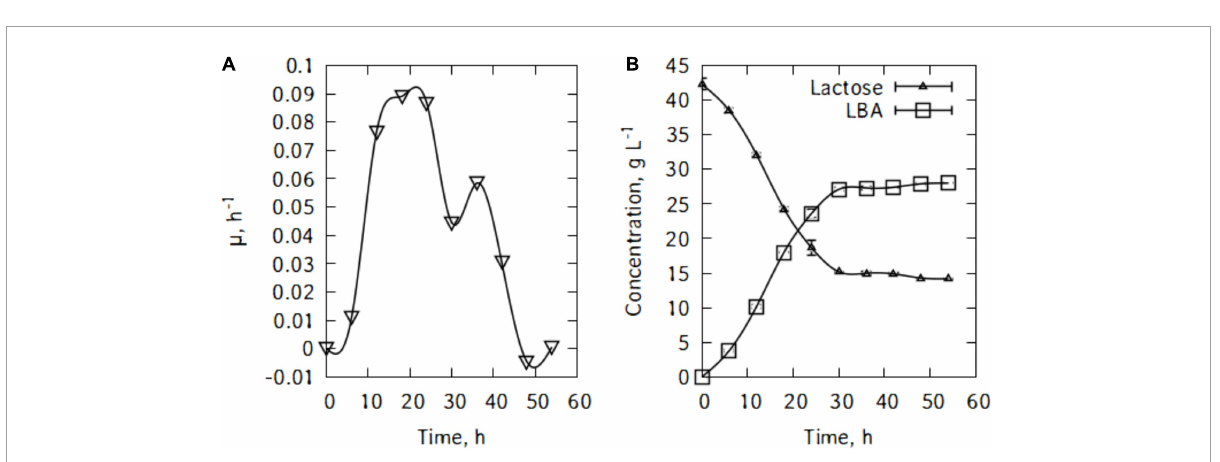
FIGURE2 (A) Specific growth rate of P. taetrolens in traditional cheese whey, (B) lactose consumption and lactobionic acid production.